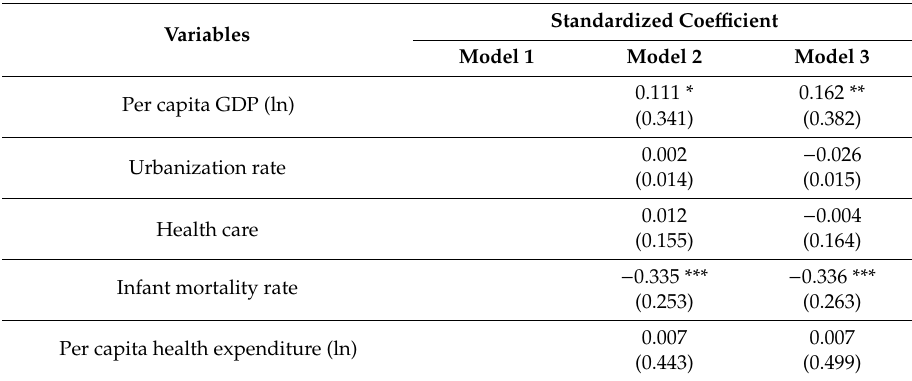
Table 3. OLS regression